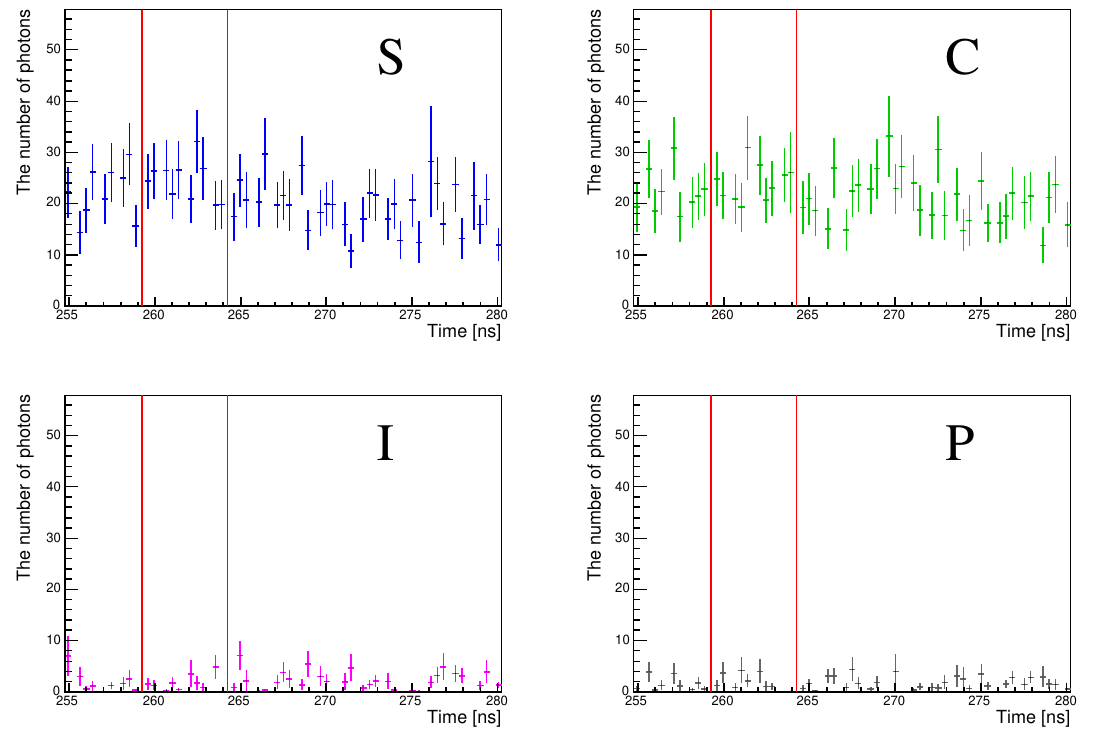
Figure 11 . Arrival-time distributions of detected photons at 2 . 6 × 10 − 5 Pa for trigger patterns S, C, I, and P by combining the P-polarization state (creation) and the left-handed circular polarization state (inducing).